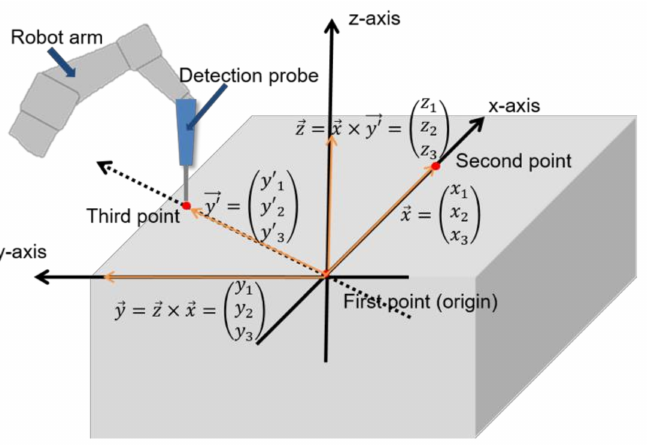
Figure 2. Overview of the three-points coordinate determination using Euler angle